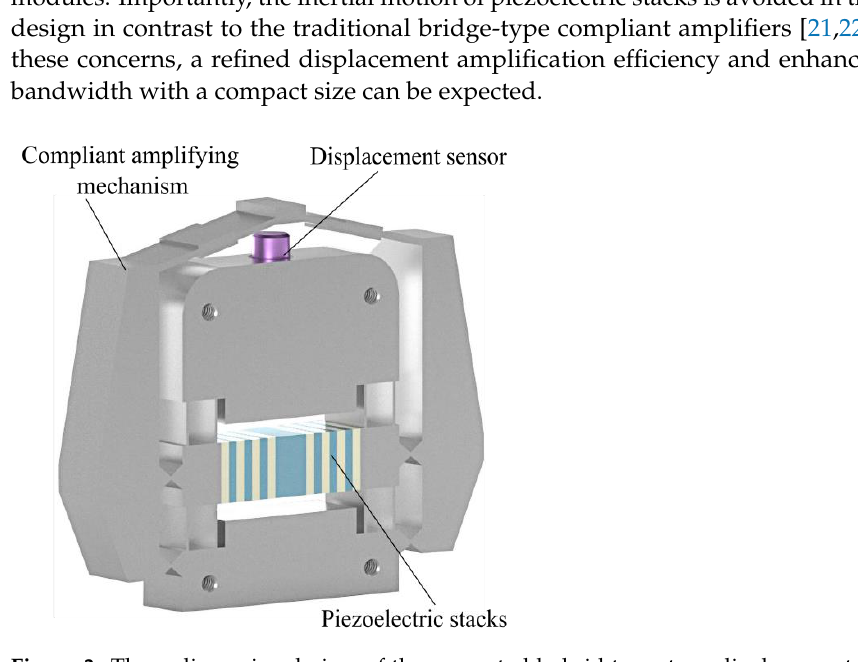
Figure 3. Three-dimensional view of the presented hybrid two-stage displacement amplification mechanism with assembled piezoelectric stacks and potential displacement sensor.